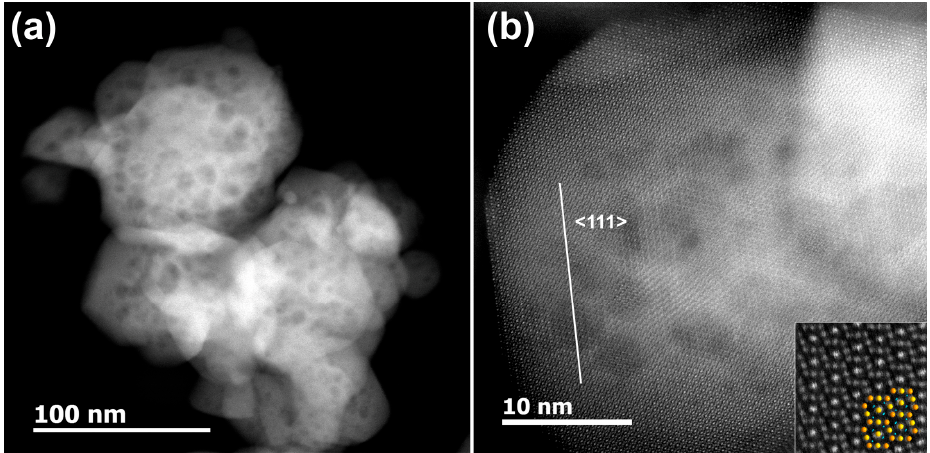
Figure 3. ( a ) Low-magnification and ( b ) high resolution HAADF-STEM images of Co 3 O 4 nanoparticles viewing along the [011] zone axis. An enlarged image with overlapped structural model (Co—orange, O—blue) is given as inset.